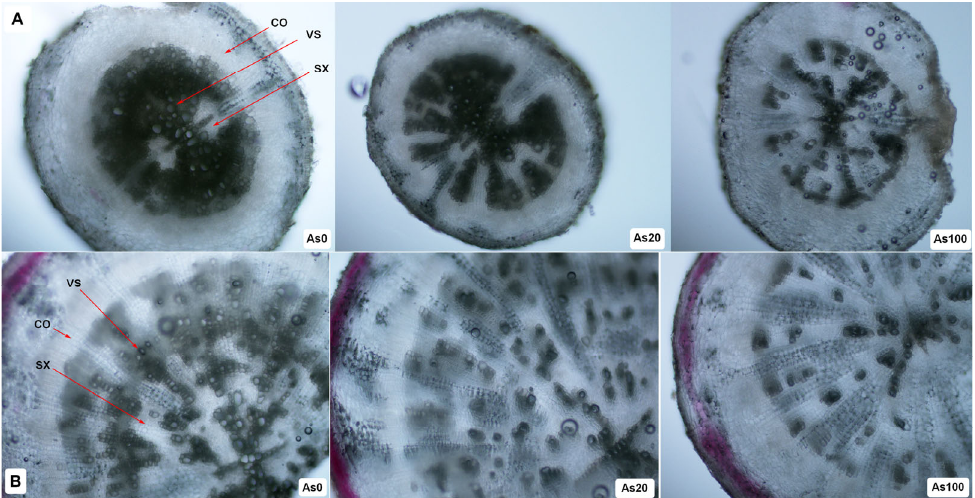
Figure 4. Cross section through root ( A , 100× magnification) and tuber ( B , 200× magnification) of cherry radish. Abbreviations: As0—0 mg As/kg soil; As20—20 mg As/kg soil; As100—100 mg As/kg soil; CO—cortex; SX—secondary xylem; VS—vessels.